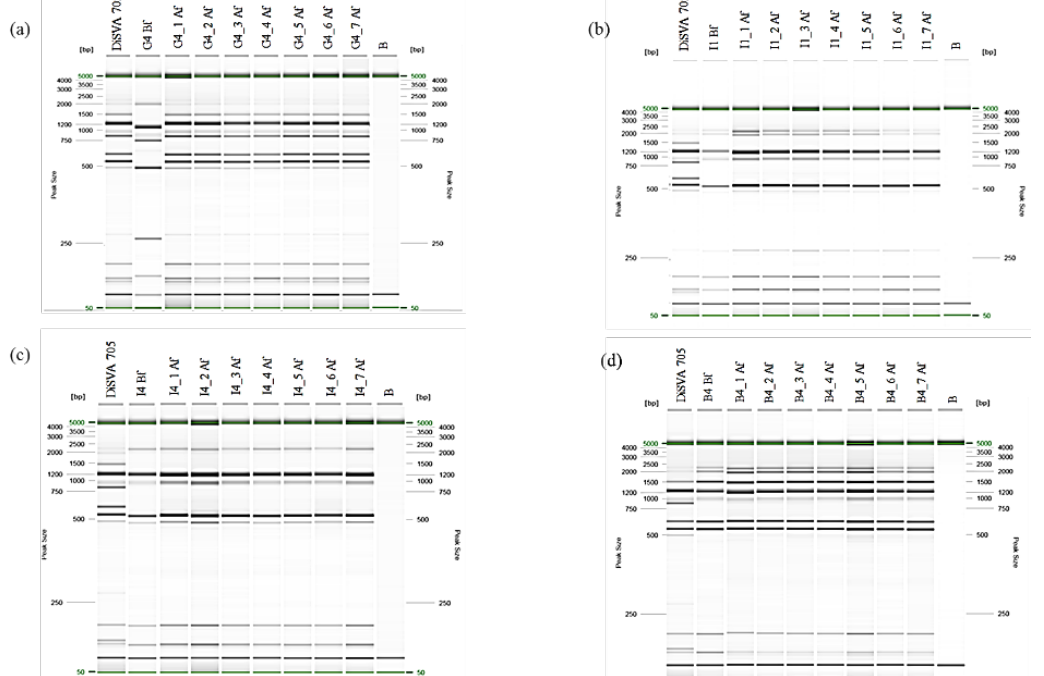
Figure 3. Electrophoretic profiles of interdelta sequences obtained by primer pair δ 12–21. Each stable isolate, belonging to each group, was named from 1 to 7 preceded by strain’s name and compared with the same unstabilized strain. The DiSVA 705 strain was used as control. The acronyms “Bf” and “Af” were used to indicate before and after genome stabilization, respectively. Lane B: indicated as negative control. The QX Size Marker 50 bp/ 5kb (Qiagen) was used for fragment size. ( a – d ) represent the electrophoretic profiles of G4, I1, I4 and I4, before and after stabilization, respectively.